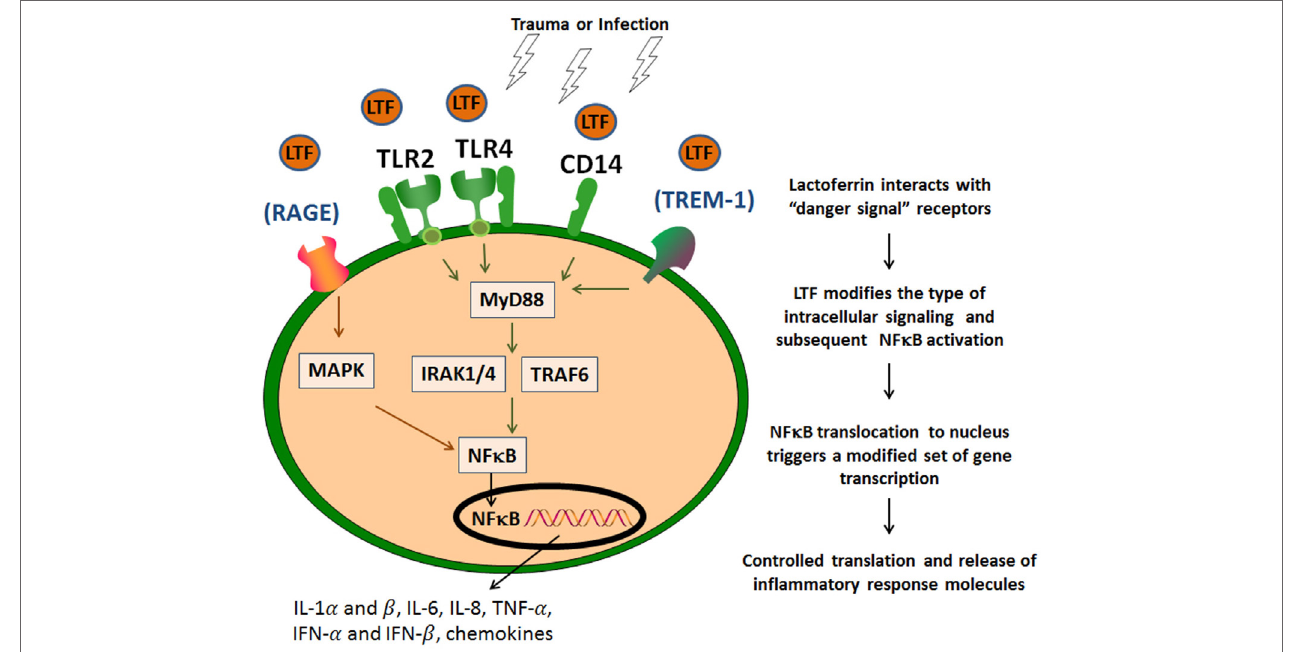
FigURe 2 | Lactoferrin (LTF) affinity to “danger signal” receptors. LTF modifies the type of intracellular signaling and subsequent NF- κ B activation via identified danger signal receptors [toll-like receptor (TLR)2, TLR4, and CD14]. This results in a modified subset of proteins to control and contain the inflammatory response. LTF may also act via other additional signaling receptors, such as RAGE or TREM-1, which also utilize NF- κ B activation